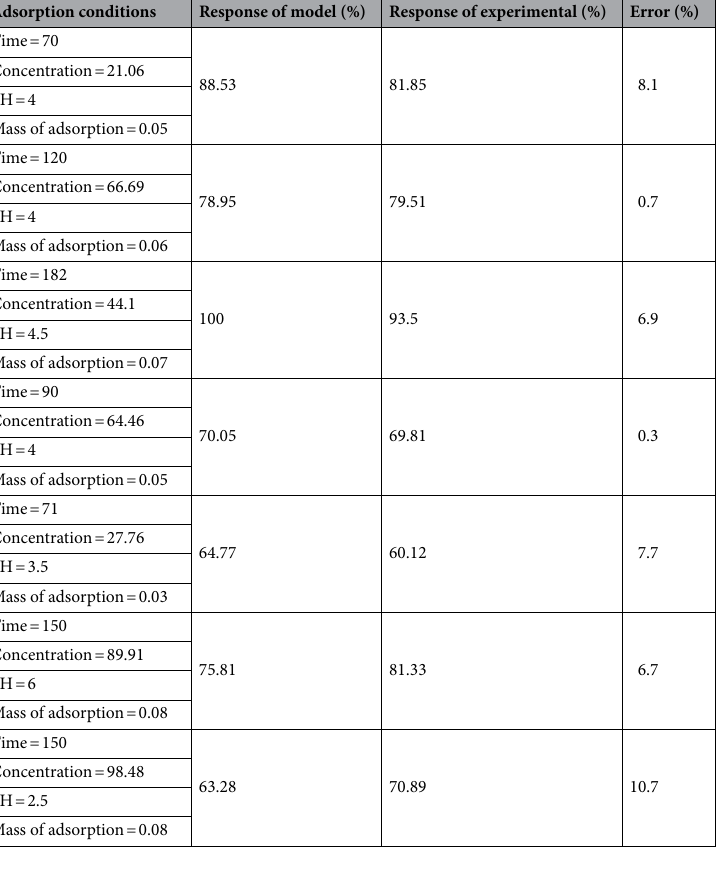
Table 6. Comparison of cobalt adsorption results from modeling and experimental.